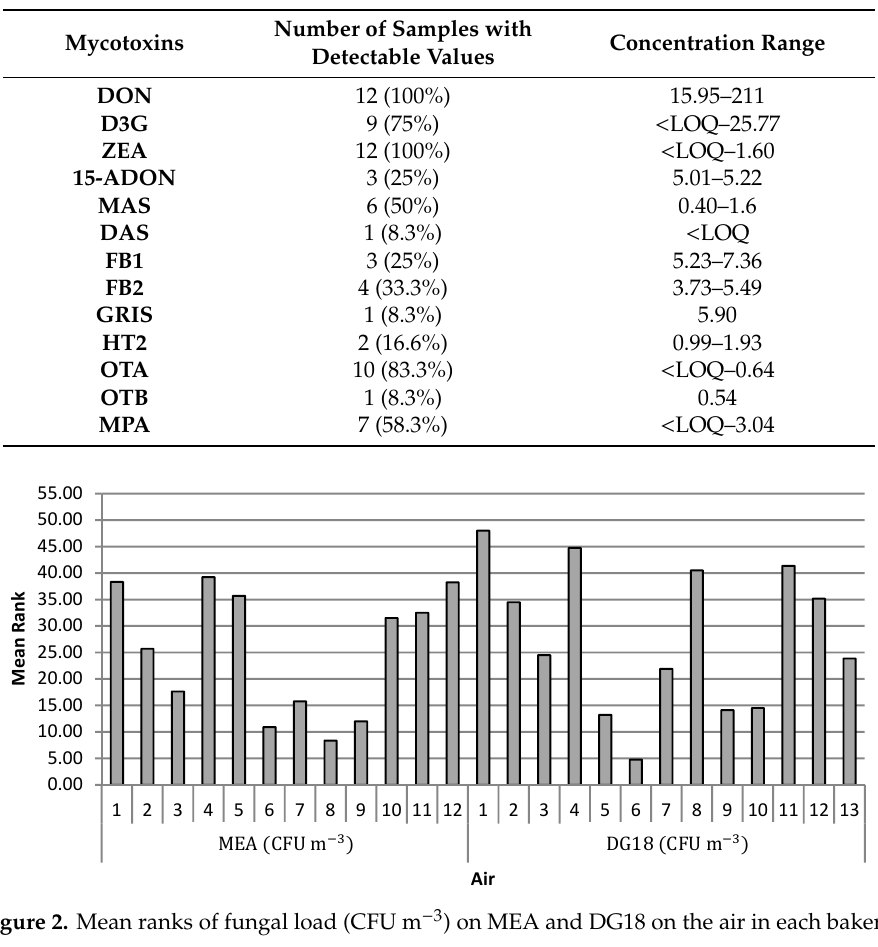
Figure 2. Mean ranks of fungal load (CFU m − 3 ) on MEA and DG18 on the air in each bakery.